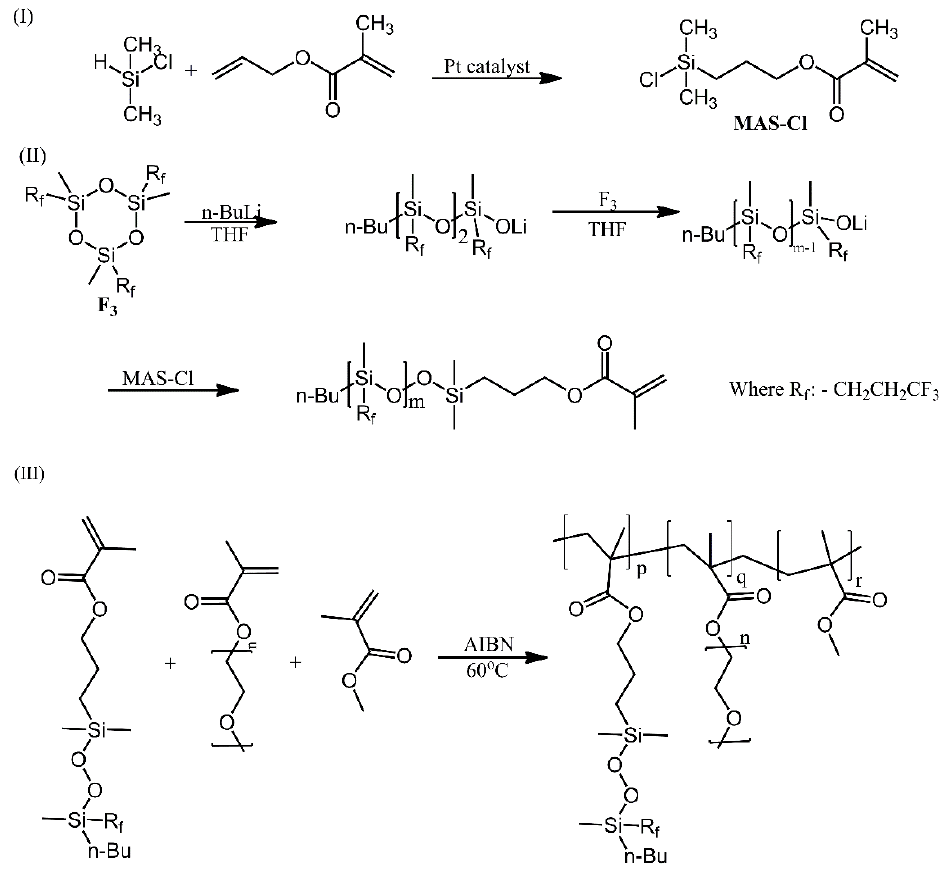
Figure 16. Synthesis of PMTFPS-MA macoromonomers and amphiphilic PMMA-g (PEG, PMTPPS) graft copolymers. AIBN: Azobisisobutyronitrile. Based on Ref. [8].